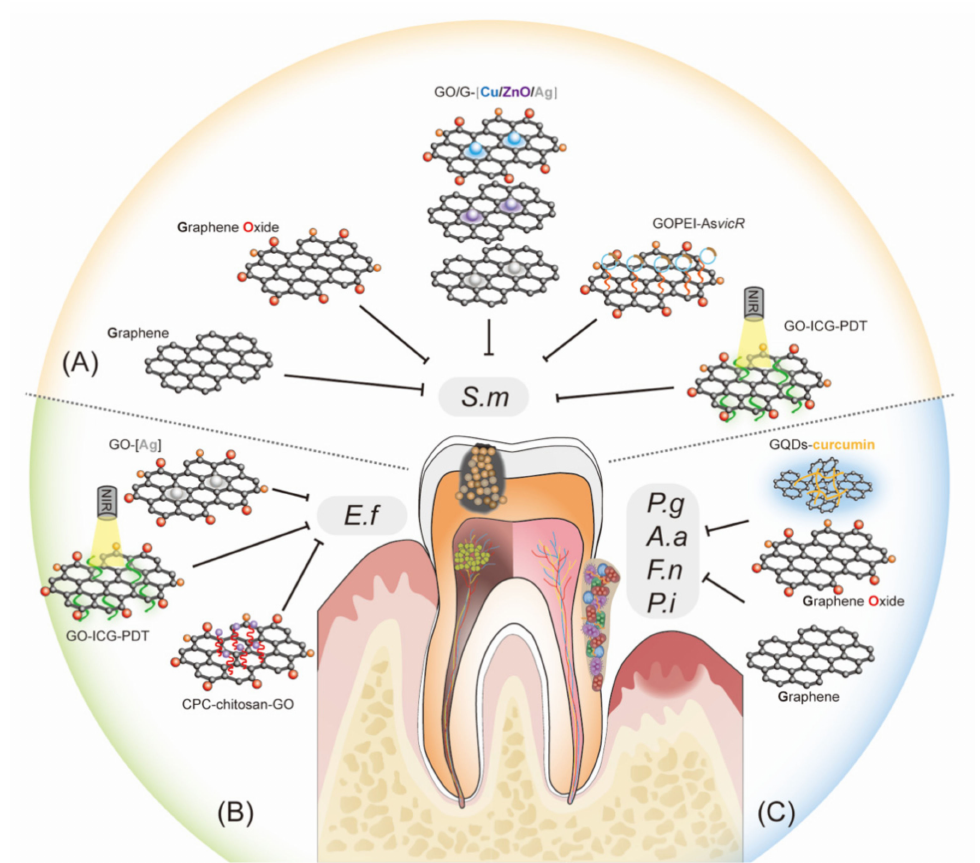
Figure 1. Graphene-based materials can inhibit oral bacteria. ( A ) Inhibiting cariogenic bac- teria: graphene (G) and graphene oxide (GO) may directly inhibit S. mutans and indirectly suppress S. mutans by enhancing the antibacterial properties of metallic nanomaterials such as silver (Ag), copper (Cu), and zinc oxide (ZnO) nanoparticles. GO may also be combined with new technologies to achieve its antibacterial activity against S. mutans by delivering nucleic acids and photosensitizers. ( B ) Control dental pulp infection: Ag–GO particles, cal- cium phosphate cement (CPC) incorporated with chitosan and GO (CPC–chitosan–GO), and antimicrobial photodynamic therapy (PDT) using indocyanine green (ICG) as a photosensi- tizer delivered by GO (GO–ICG–PDT) can effectively reduce the biovolumes of E. faecalis . ( C ) Suppression of periodontal pathogens: GO, G, and graphene quantum dots (GQDs) cou- pled with curcumin (GQDs–curcumin) may inhibit the growth and multispecies biofilm forma- tion of periodontal pathogens, such as P. gingivalis , A. actinomycetemcomitans , F. nucleatum , and P. intermedia . S.m , Streptococcus mutans ; E.f , Enterococcus faecalis ; P.g , Porphyromonas gingivalis ; F.n , Fusobacterium nucleatum ; A.a , Aggregatibacter actinomycetemcomitans ; P.i , Prevotella intermedia ; PEI, polyethylenimine ; AsvicR, Antisense vicR